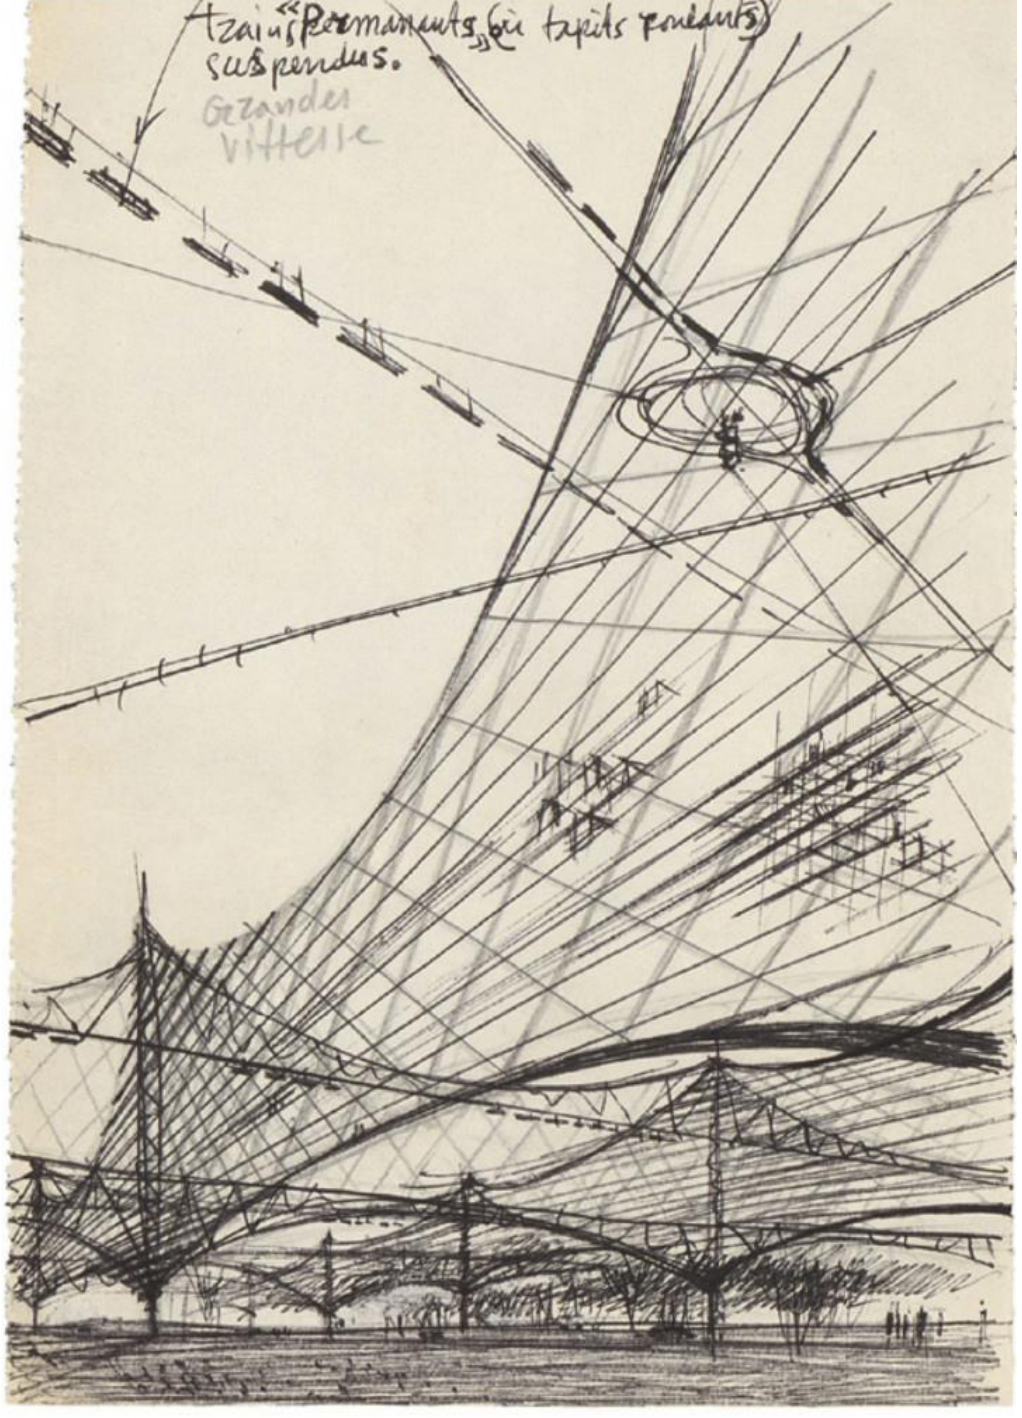
Figure 7. Takis Zenetos, sketch for the “Suspended city” (“Ville suspendue”), 1961. Image courtesy of the Takis Ch. Zenetos Archive.